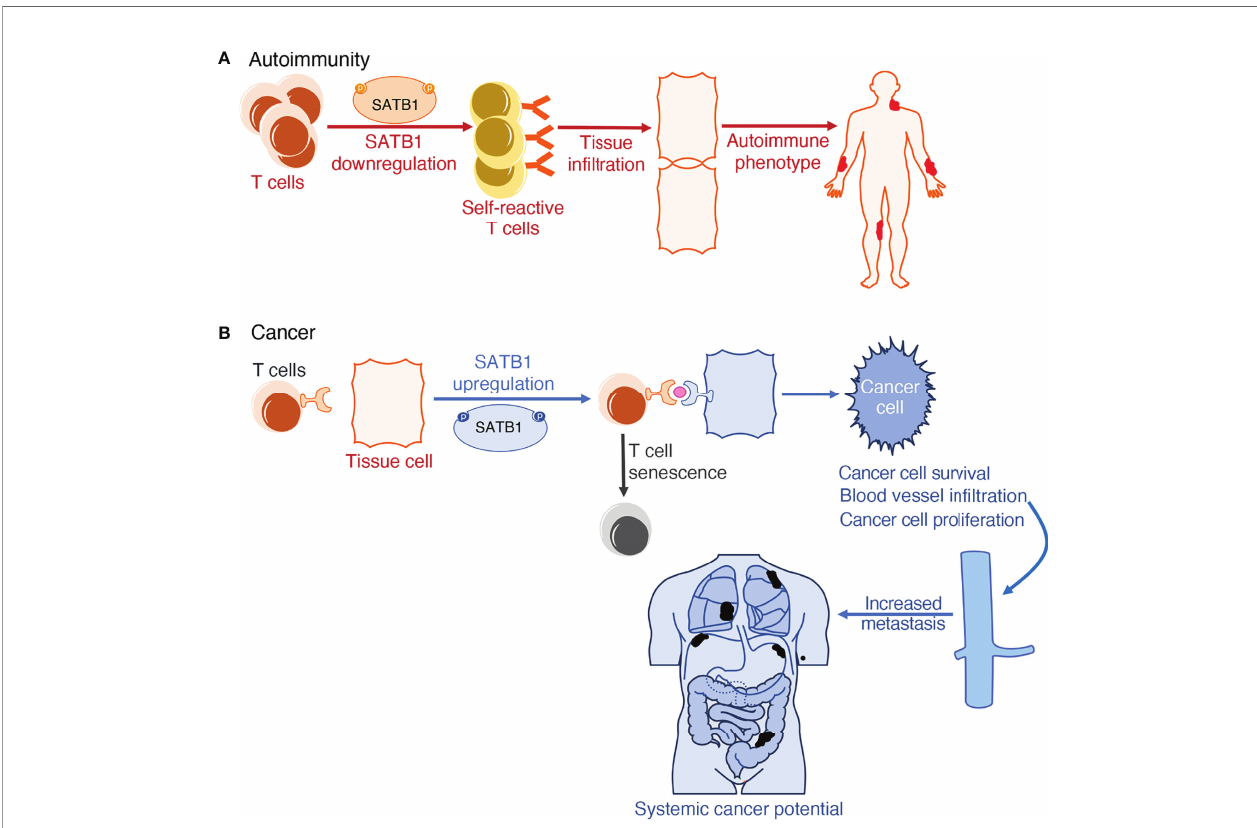
FIGURE 2 | Schematic representation of SATB1 deregulation in (patho)physiology. (A) SATB1 downregulation in thymic T cells results in defective T cell training in the thymic medulla. When these self-reactive T cells circulate in the lymphatic system, they fail to recognize pathogens and instead misidentify a person ’ s autoantigens as hostile. This induces T cell in fi ltration in tissues, further accentuating in fl ammation observed in autoimmune phenotypes in both humans and mice. (B) SATB1 expression upregulation in normally non-expressing tissue cells is the tell-tale mark of multiple cancers. SATB1 boosts the expression of the PD1/PDL1 pathway which is responsible for both T cell senescence and exacerbating deterioration markers in cancer; namely cancer cell proliferation, differentiation, survival, and potential for